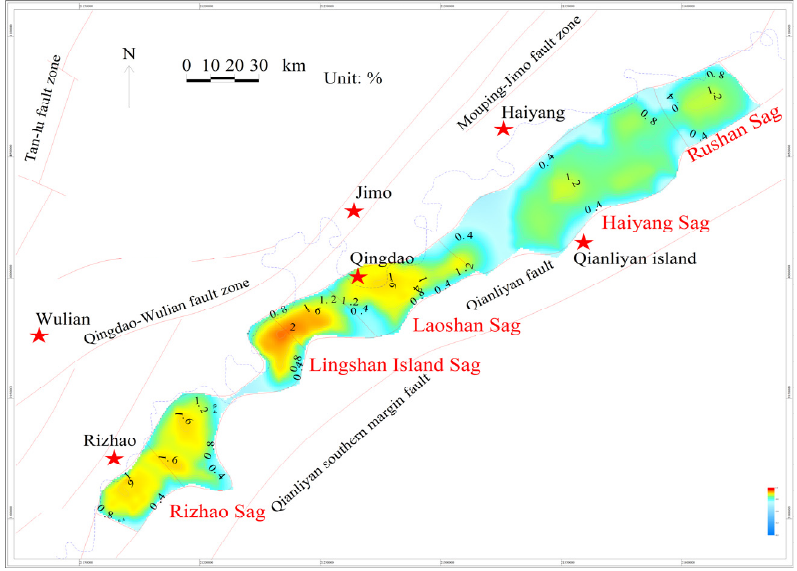
Figure 7. Contour map of TOC in the Laiyang Formation in the Ri-Qing-Wei Basin.